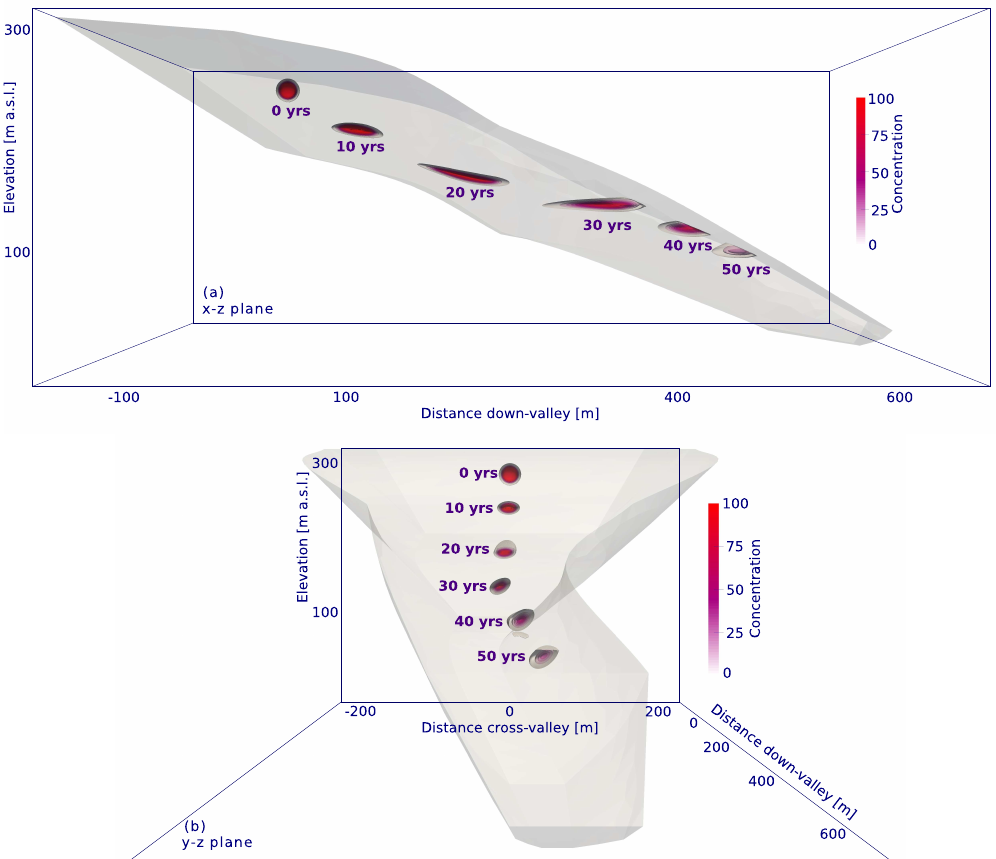
Figure 10. Results of the debris transport simulations for the 3-D idealized glacier. Debris concentration isosurfaces of concentration 1, 10–100 in steps of 10 are displayed for a cut through (a) the x – z plane and (b) the y – z plane, as labelled in the figure. The isosurfaces shown refer to time 0–50 years after the start of the simulation in an interval of 10 years. Concentrations are displayed in the range of 0 to 100, numerical oscillations as excursions beyond the initial values of 0 or 100 are of magnitude less than ± 4 and are truncated to the data